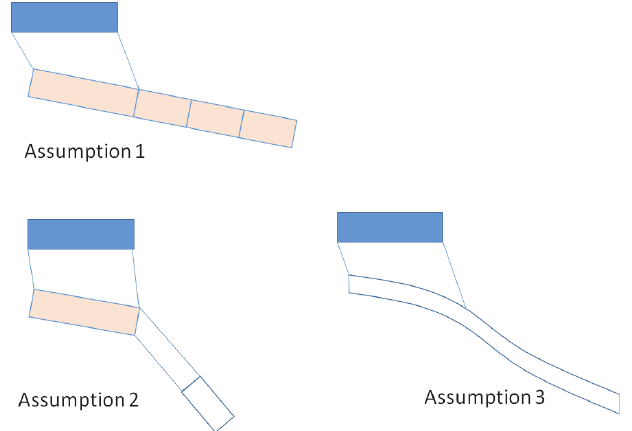
Fig. 11: Representation of the possible assumption that can be made about the attachment of broken laminate to the joint. The first case is not relevant because it assumes that the flexural rigidity of the broken laminate is much greater than joint rigidity, which is the case before glass plies breakage but not after. The second case assumes a change of slope of laminate deflection at joint extremity, having a free rotation connection at this point. The third case assumes that the membrane stays soft, even at joint location. The case 2 seems the more realistic because the laminate should